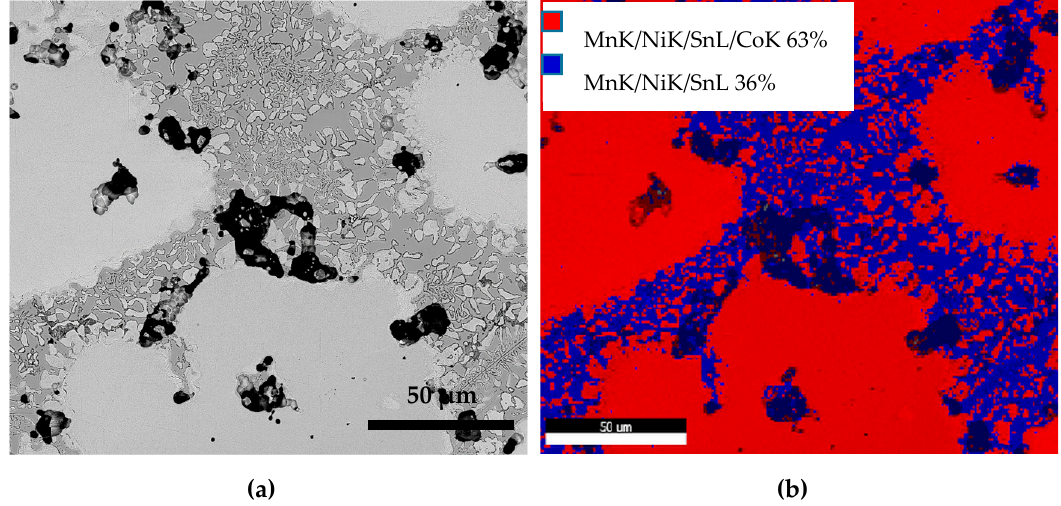
Figure 12. ( a ) BSE micrograph of S1050a3 and ( b ) compositional map of the microstructure.